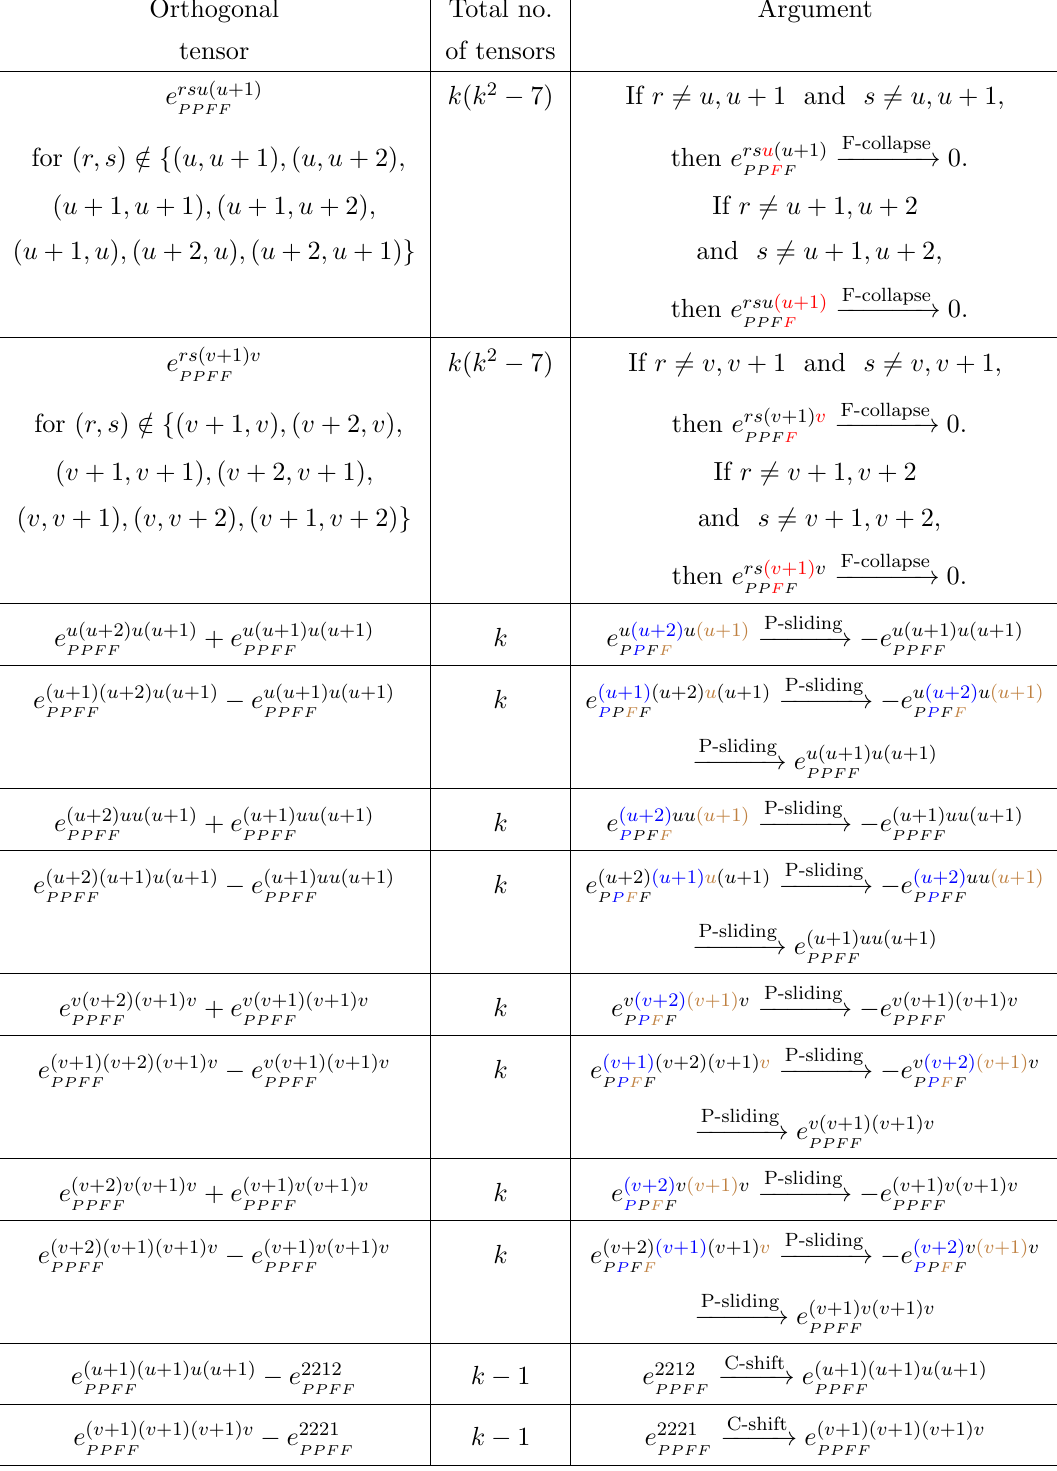
Table 10 . Arguments for the tensors in the PPFF sector orthogonal to the array of 4 point contour